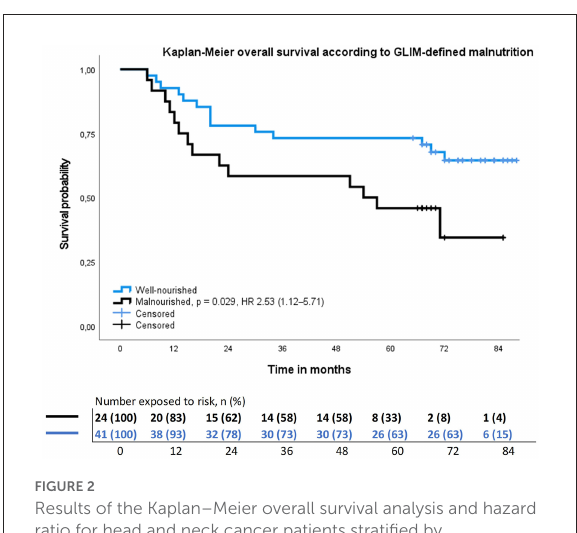
FIGURE2 Results of the Kaplan–Meier overall survival analysis and hazard ratio for head and neck cancer patients stratified by GLIM–defined nutrition status. Hazard ratio adjusted to age, gender, stage, and smoking.